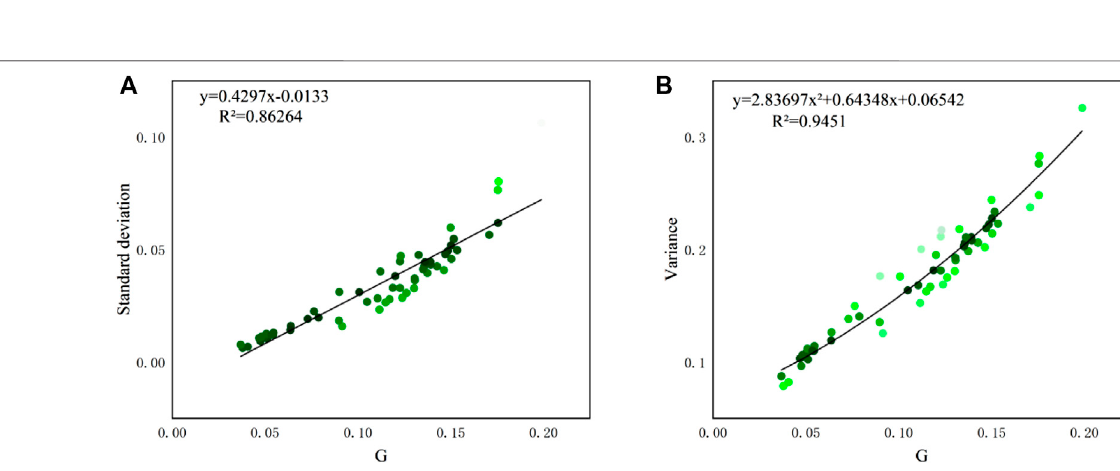
Frontiers in Environmental Science |